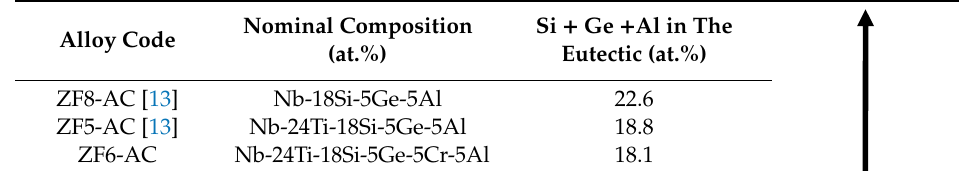
Table 8. Concentration of Si + Ge + Al in the Nb ss + β Nb 5 Si 3 eutectic in the as cast alloys ZF5, ZF6 and ZF8.